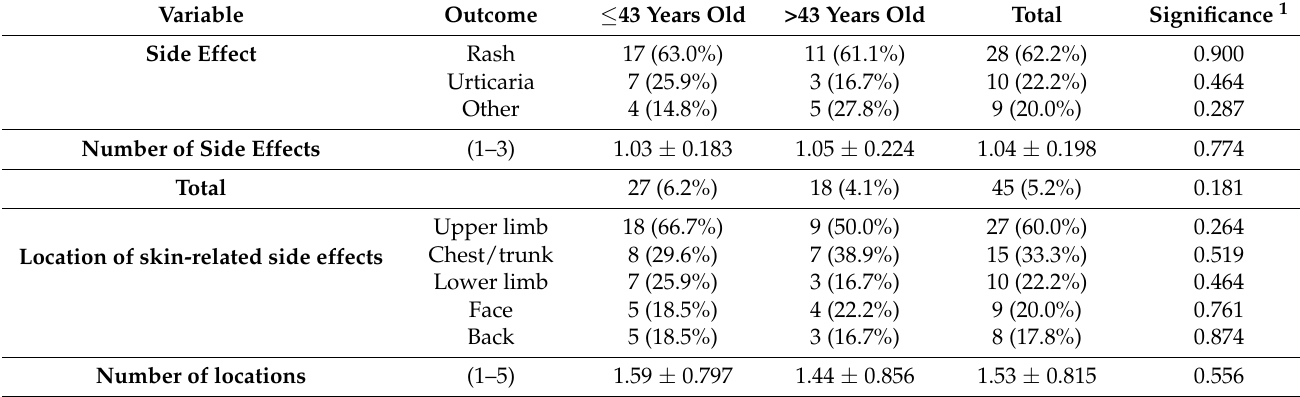
Table 8. Prevalence of skin-related side effects of the Pfizer–BioNTech COVID-19 vaccine among healthcare workers in the Czech Republic, January–February